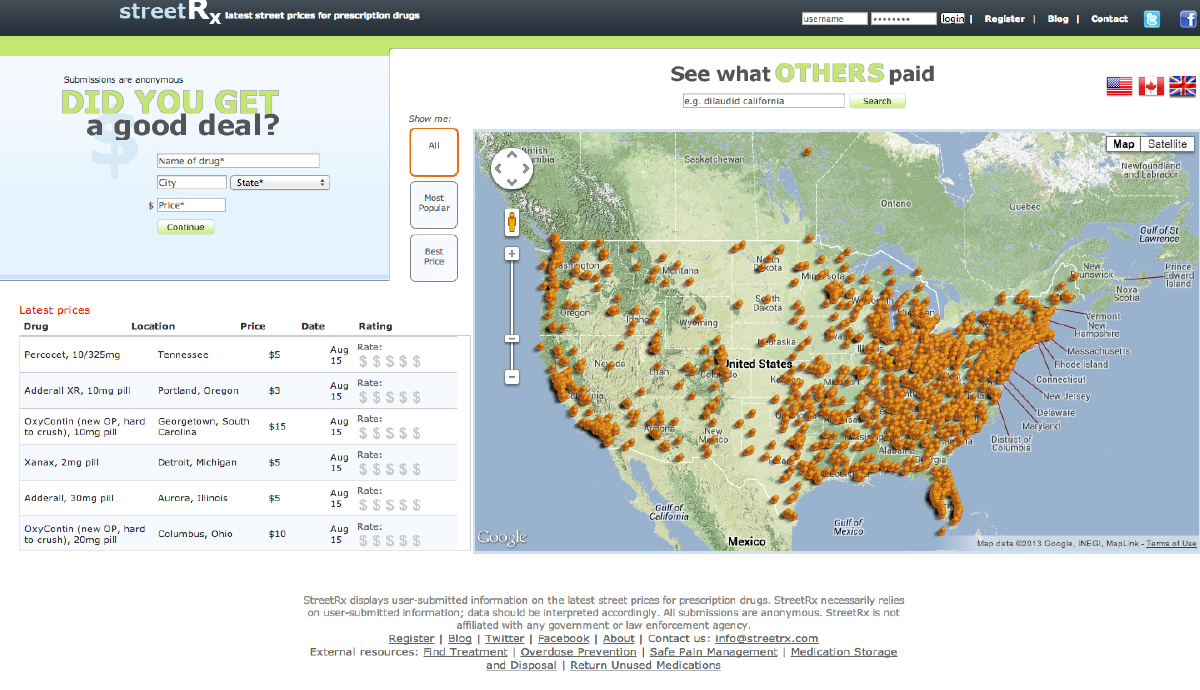
Figure 1. Screenshot of StreetRx - features street price data on diverted pharmaceutical controlled substances for public health research